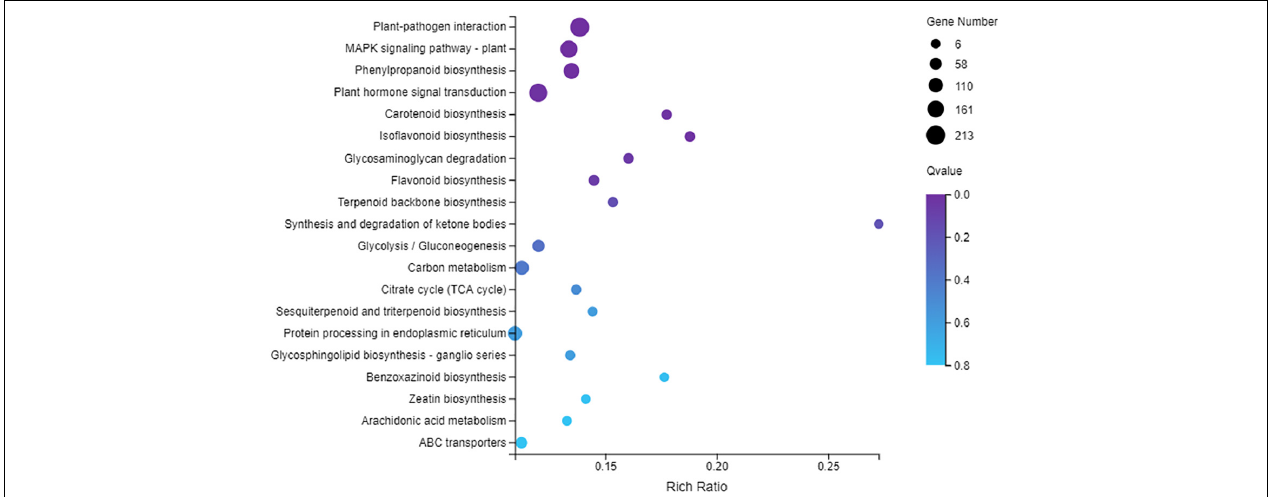
FIGURE 3 | Statistics of KEGG Pathway Enchrichment scatter diagram of DEGs between infected roots of Handou 10 and Zheng 9525. The 20 most enriched pathways are displayed.